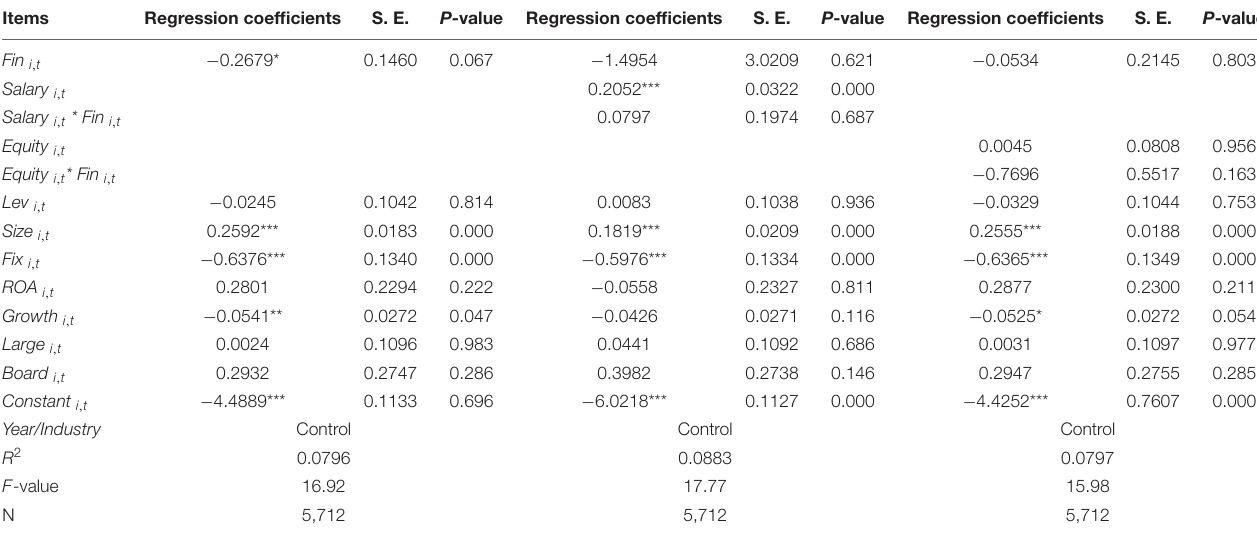
TABLE 14 | Property heterogeneity (non-state-owned